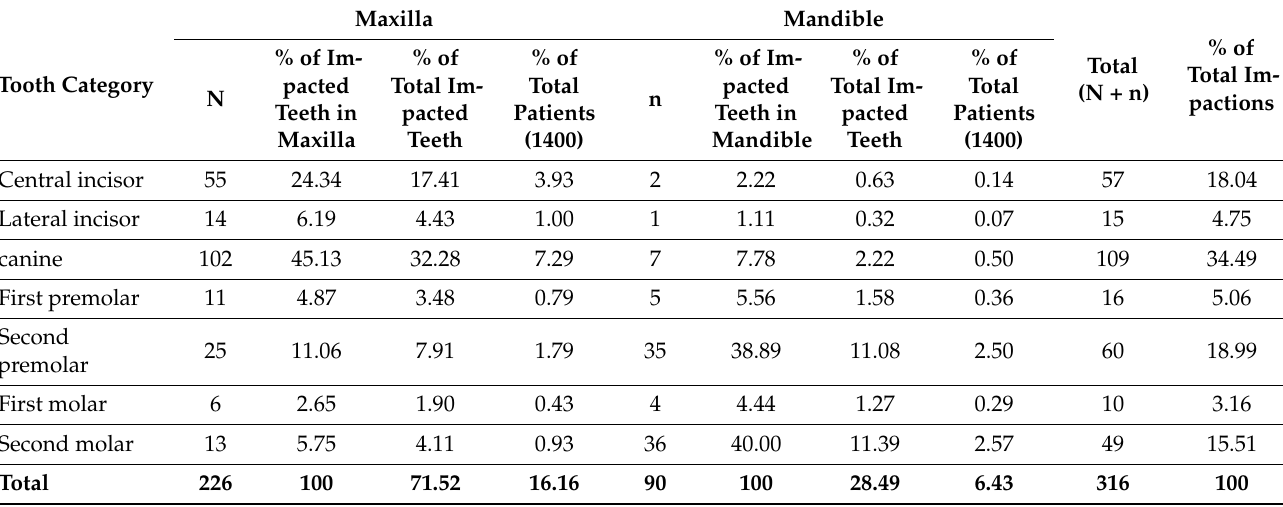
Table 1. Distribution of impacted teeth.